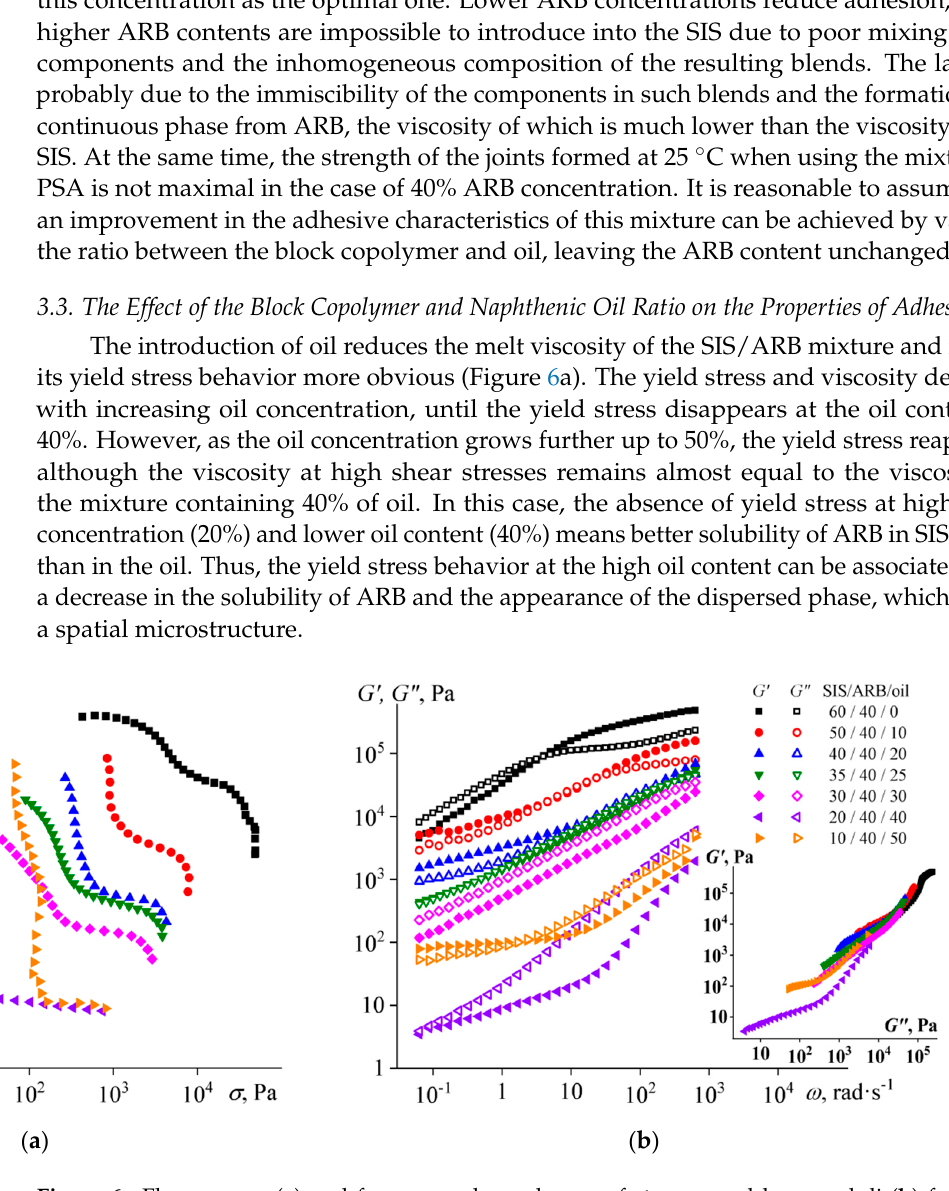
Figure 6. Flow curves ( a ) and frequency dependences of storage and loss moduli ( b ) for triple mixtures containing the same concentration of asphaltene/resin blend (ARB) and different ratios between styrene ‐ isoprene ‐ styrene triblock copolymer (SIS) and naphthenic oil at 120 °C. The insert shows the Cole–Cole plots.